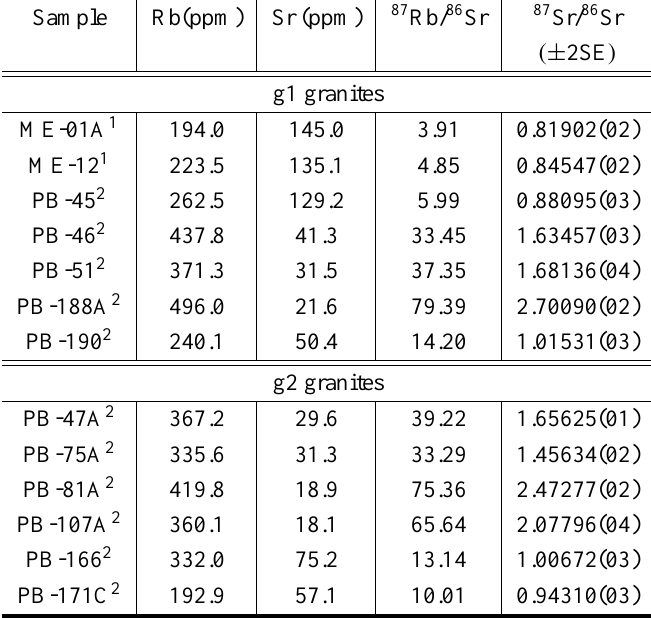
Rb-Sr isotopic data for g1 and g2